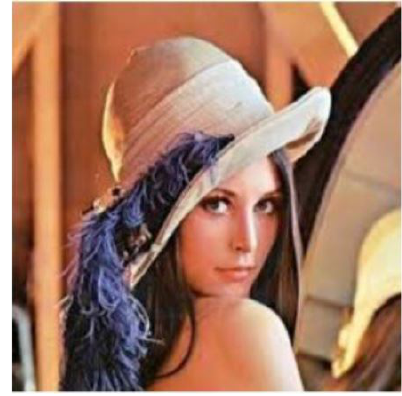
Figure 8. Encrypted image of Lena - size 174